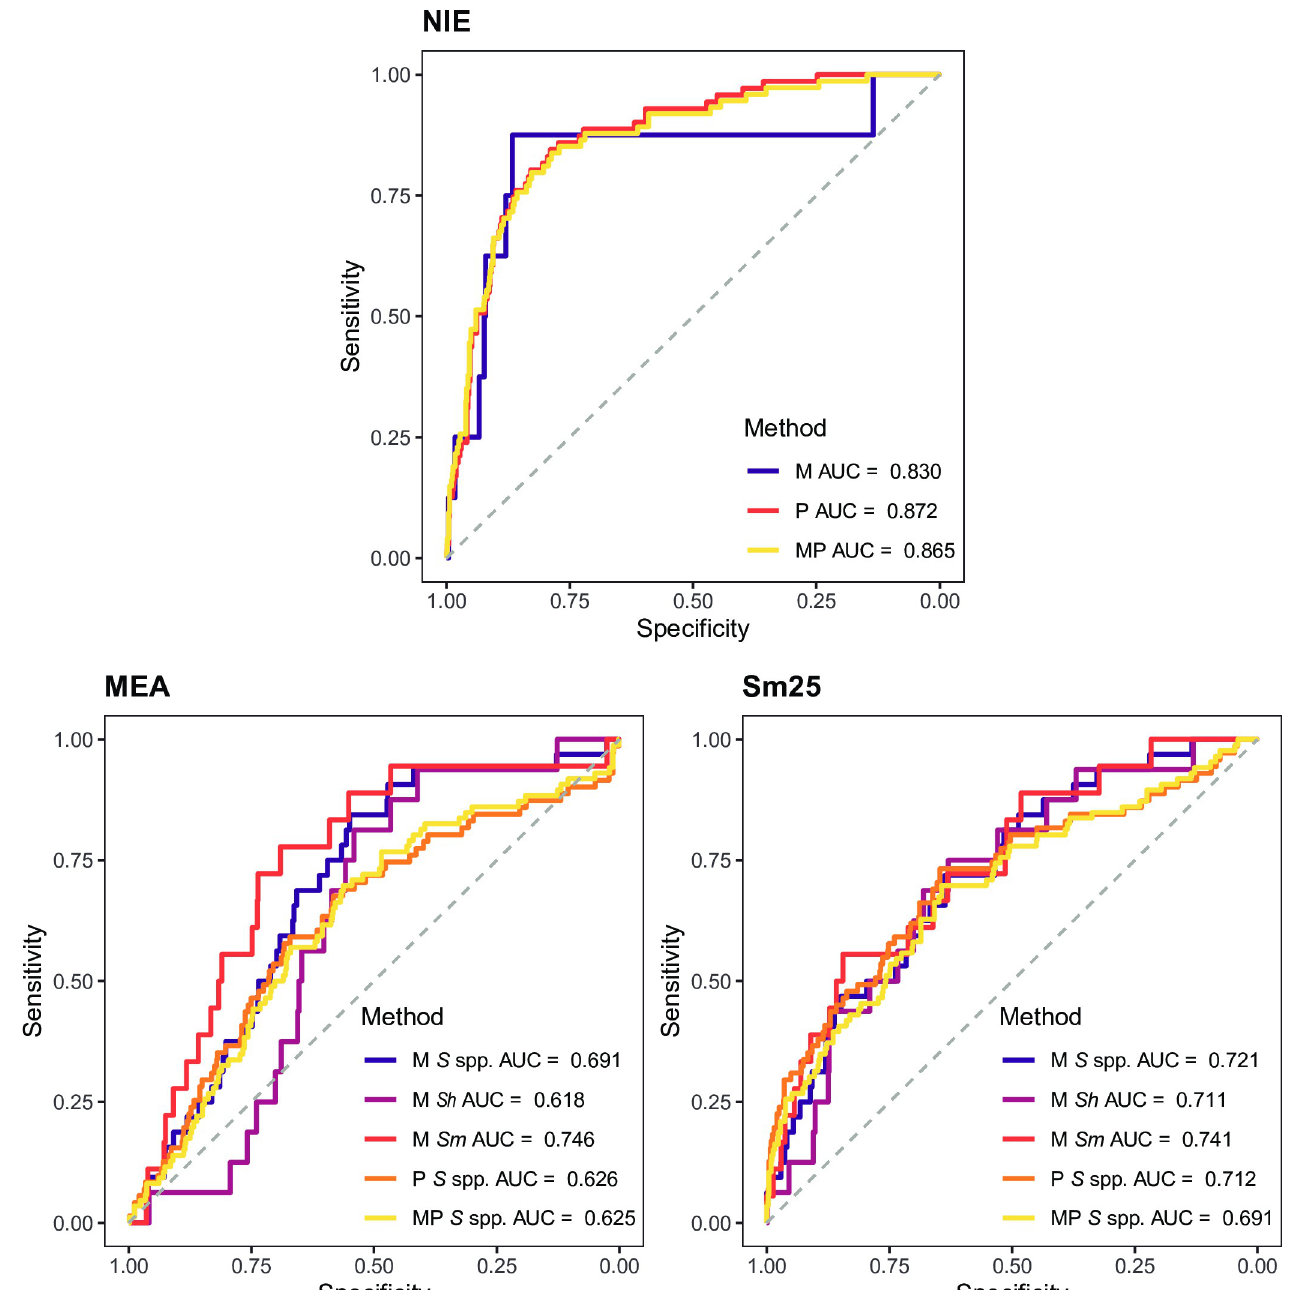
Fig 3. Receiver operating characteristic curves and their corresponding areas under the curve from the best performing IgG responses in detecting current helminths infection. IgG responses (log 10 -transformed median fluorescence intensity [MFI] levels) against S . stercoralis (NIE) and Schistosoma spp. (MEA and Sm25) antigens in serum samples from 715 endemic individuals and 50 Spanish donors were used as predictor variables. Microscopic (M), qPCR (P) or the combination of both (MP) diagnoses were used as response variables. S spp.: Schistosoma spp.; Sh : Schistosoma haematobium ; Sm : Schistosoma mansoni . AUC: Area Under the